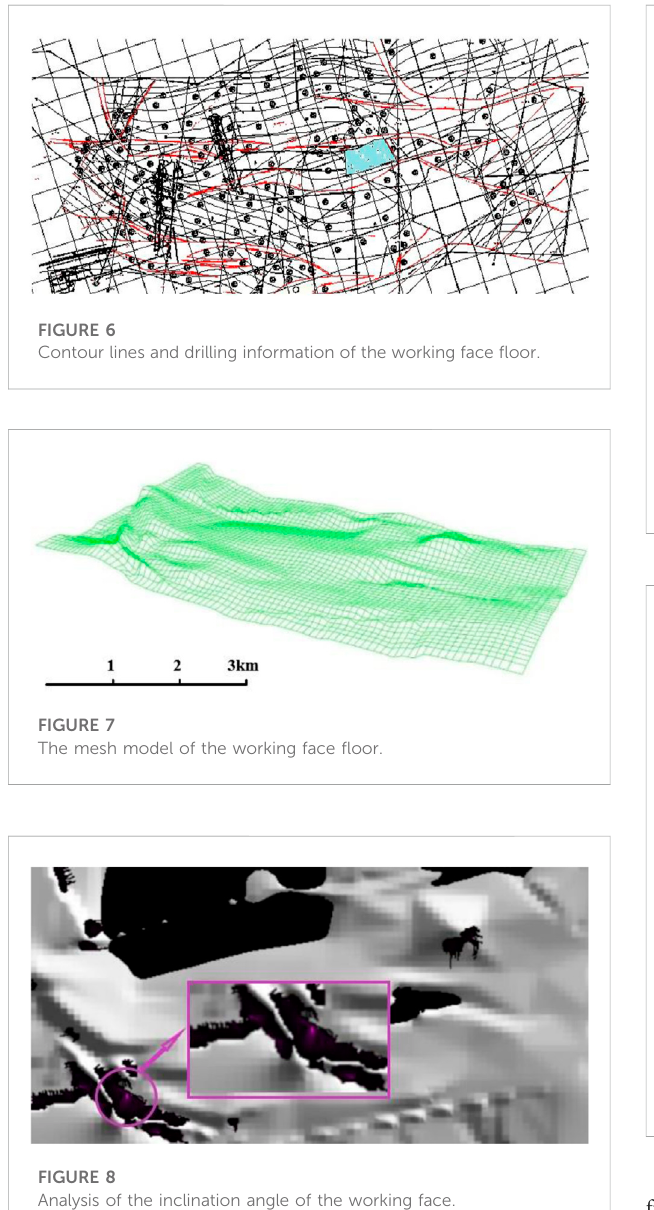
FIGURE 8 Analysis of the inclination angle of the working face.